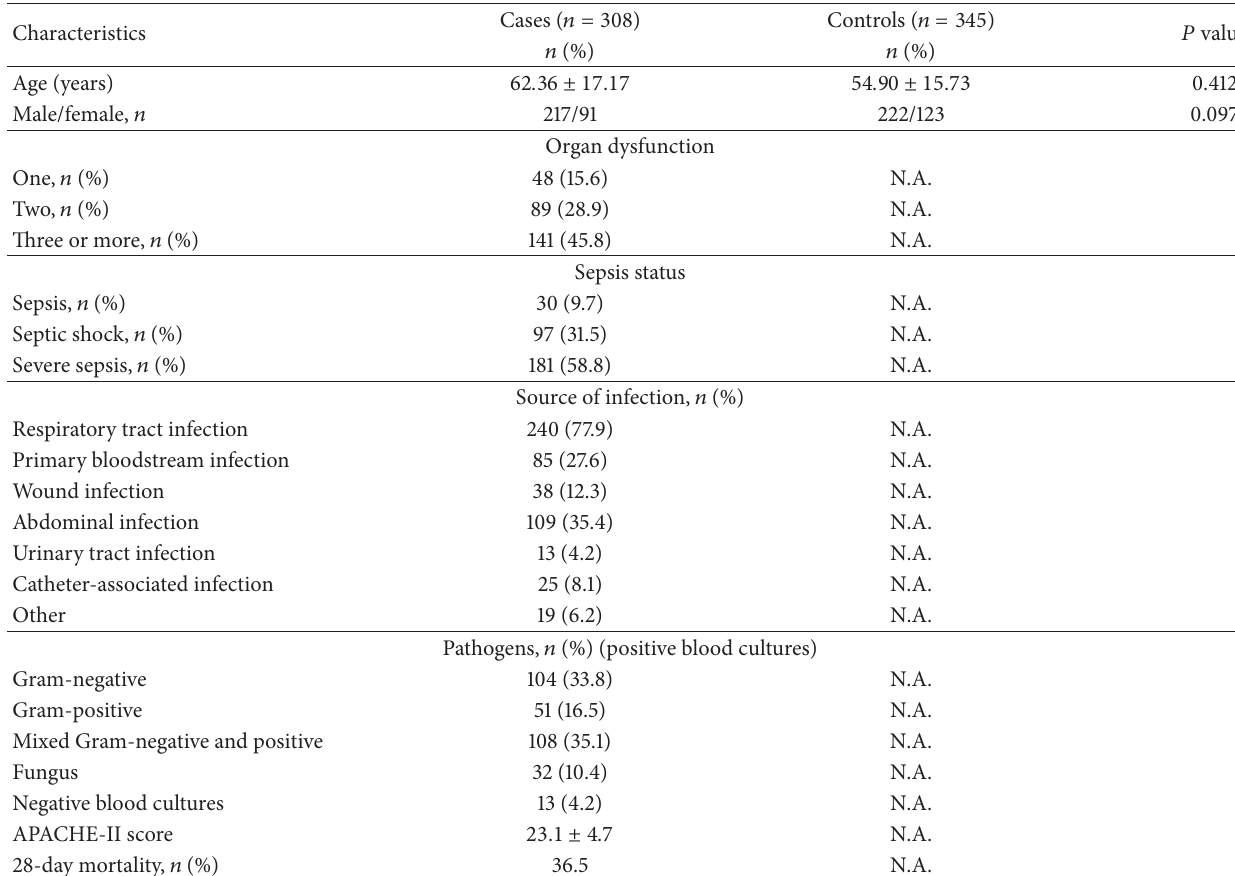
Table 1: Demographic and clinical characteristics of the study subjects in the sepsis and control groups.